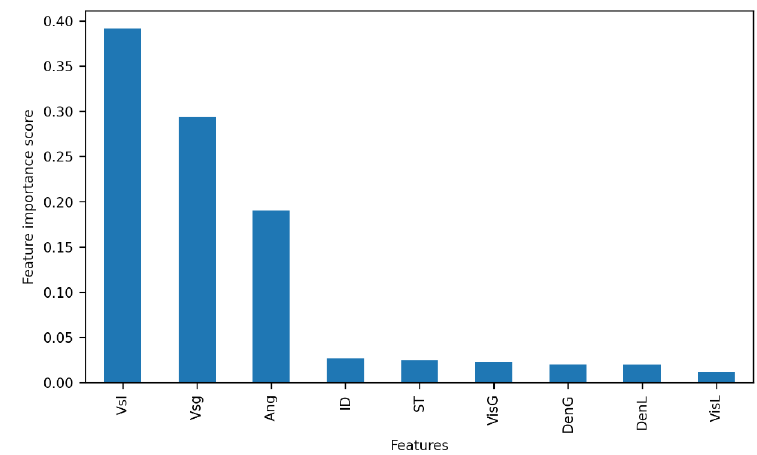
Figure 2. Feature plot ranked by ET classifier reported importance score.